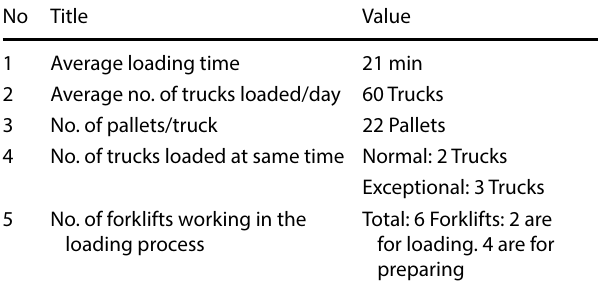
Table 1 Loading process information